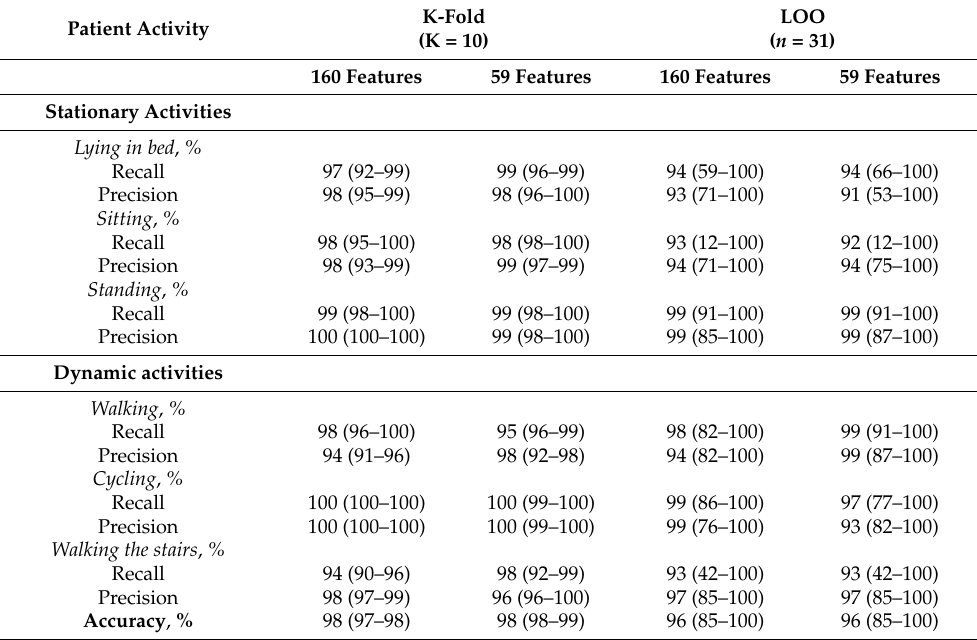
Table 4. Preoperative labelling of activities with K-fold cross validation (K = 10) and LOO